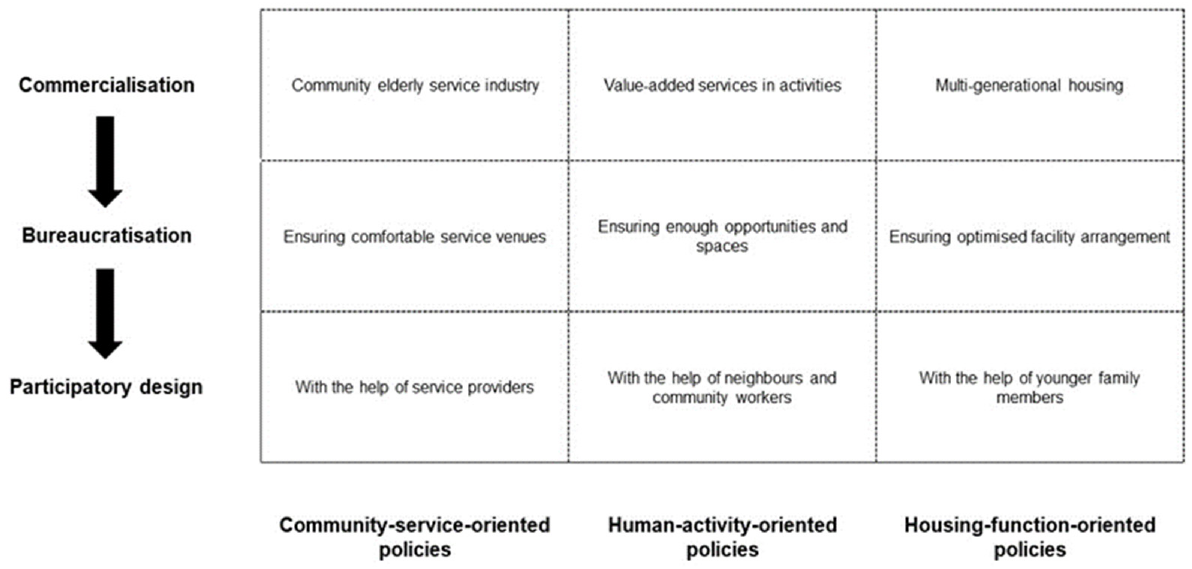
Figure 6. Policy framework for age-friendly community development.